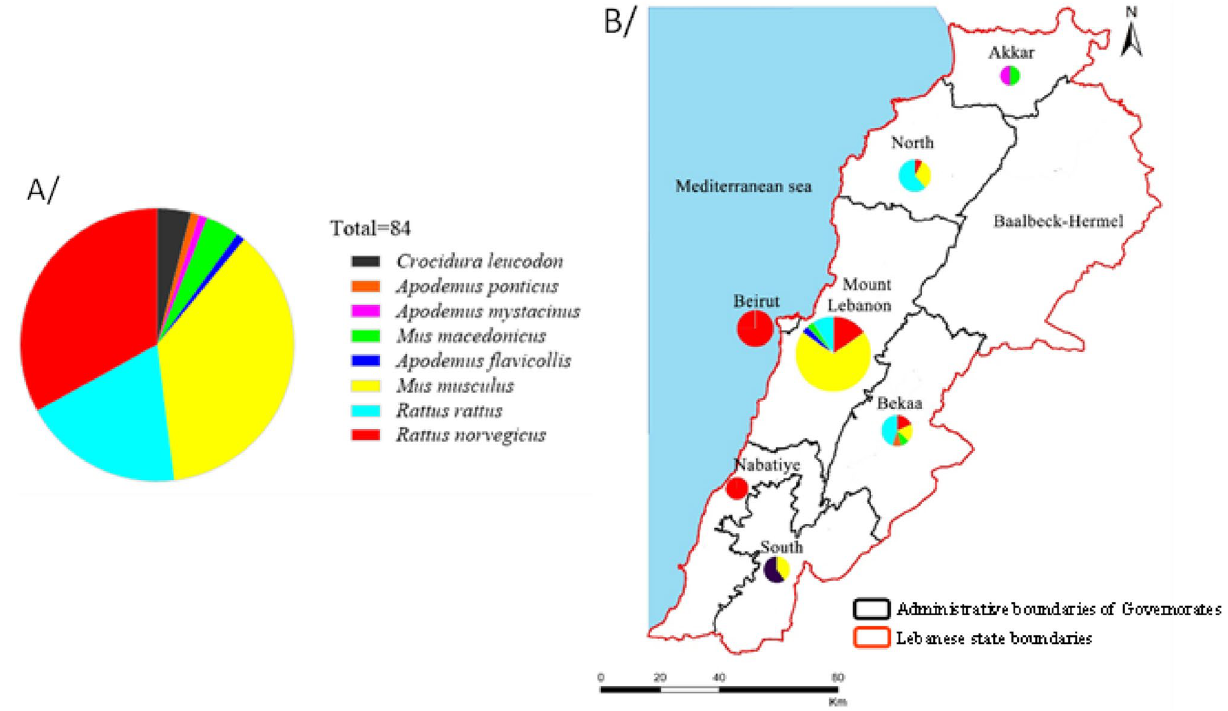
Figure 1. Distribution of species among ( A/ ) Lebanon and ( B/ ) the governorates of Lebanon.